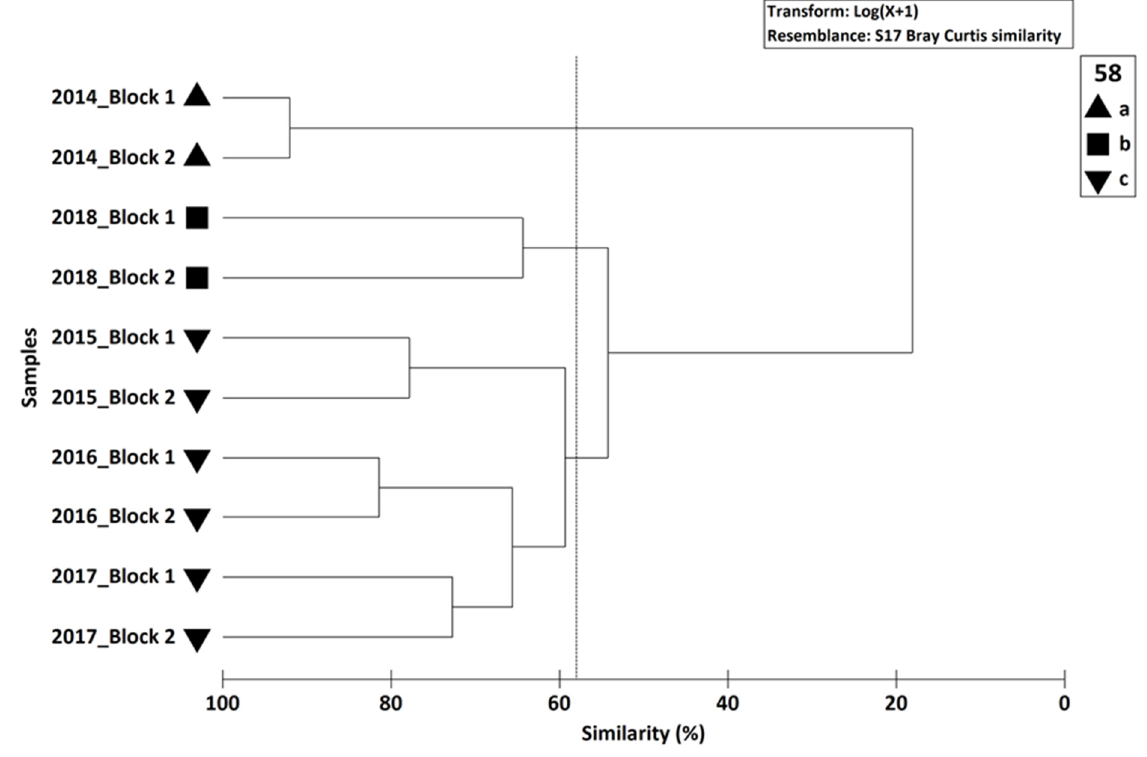
Figure 9. Cluster dendrogram showing the pattern of abundance per 0.6 m 2 of the 10 blocks after Log (X+1) transformation according to the Bray–Curtis similarity and using the mean grouping method (UPGMA).